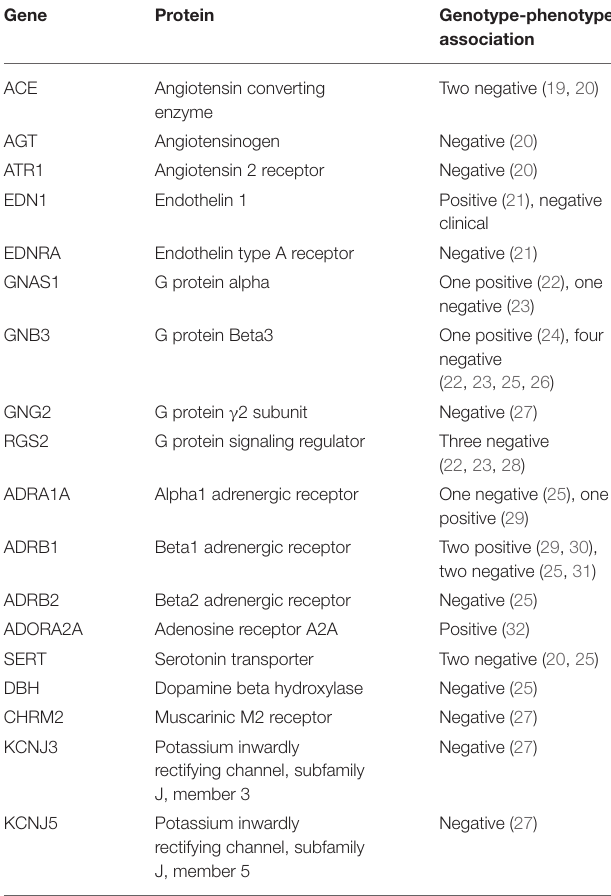
TABLE 1 | Associations between candidate gene alleles and susceptibility to induction of vasovagal syncope on tilt table